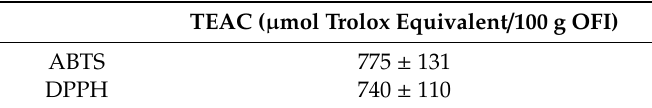
Table 4. Antioxidant activity of Opuntia ficus indica cladodes (OFI) evaluated by in vitro assays. Results are expressed as mean ± standard deviation ( n =